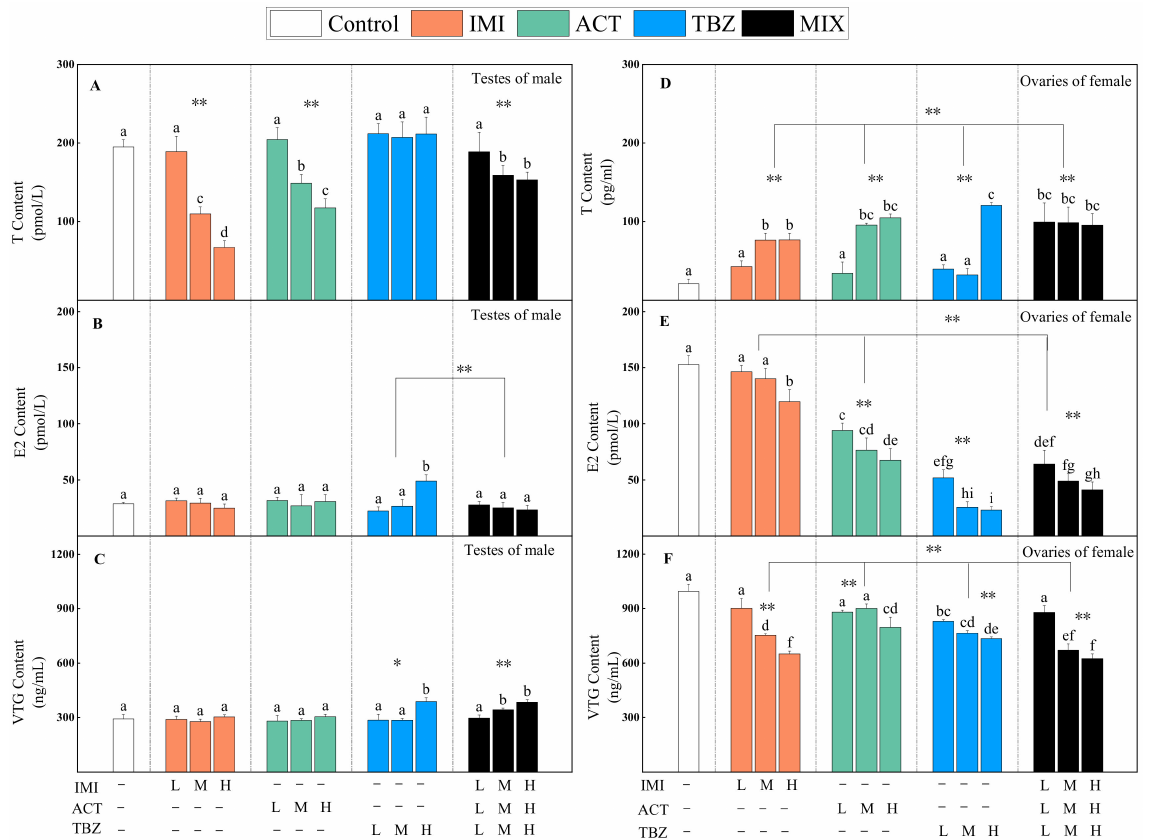
Figure 5. Contents of reproductive hormones T, E2 and VTG in the testes and ovaries: ( A – C ) the content of T, E2 and VTG in the testes; ( D – F ) the content T, E2 and VTG in the ovaries. Values are presented as mean ± standard deviation (n = 3, replicates of 50 embryos each) ( p < 0.05). Here L: low concentration, M: medium concentration and H: high concentration. In the figure, “a, b, c, . . . ” indicate that the results were analyzed by one-way ANOVA; “* and **” indicate the significant differences between the exposure groups and the control and the results were analyzed by two-way ANOVA (*: p < 0.05; **: p <